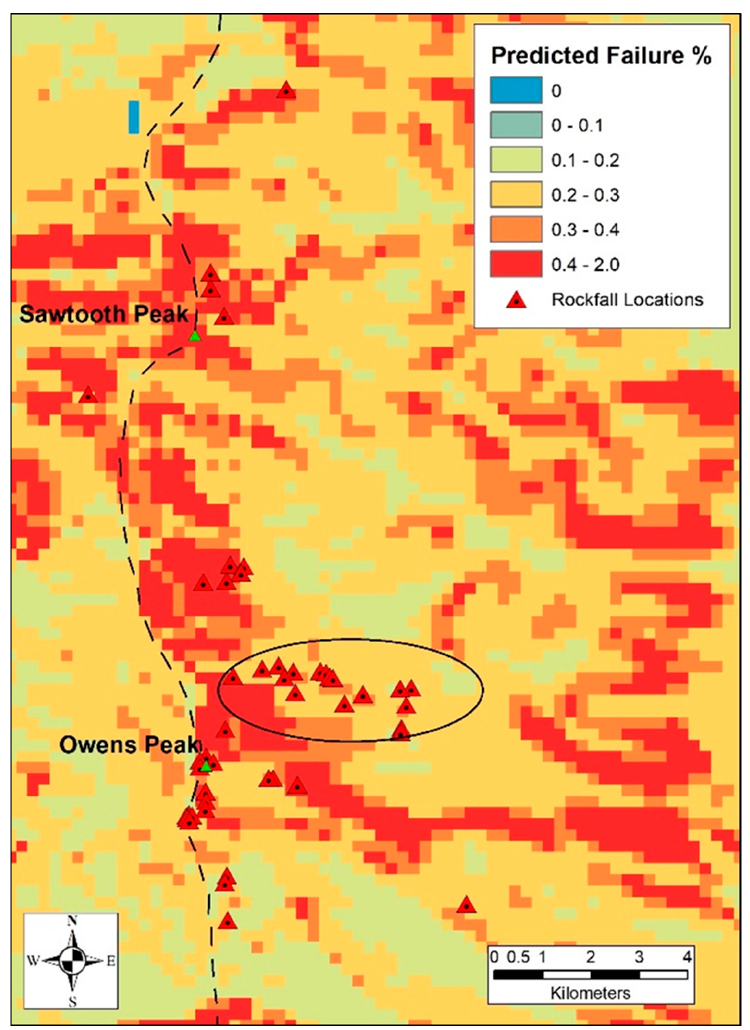
Figure 14. ShakeMap results for the Ridgecrest earthquake LS study area. Predicted slope failure percentage computed using the Jesse et al. [51] model. Red cells indicate areas with up to a 2% probability of failure within that cell for the Ridgecrest event. Anomalously oriented rockfall features in upper Grapevine Canyon shown in black oval area circle. The largest of these failures is shown in Figure 15.